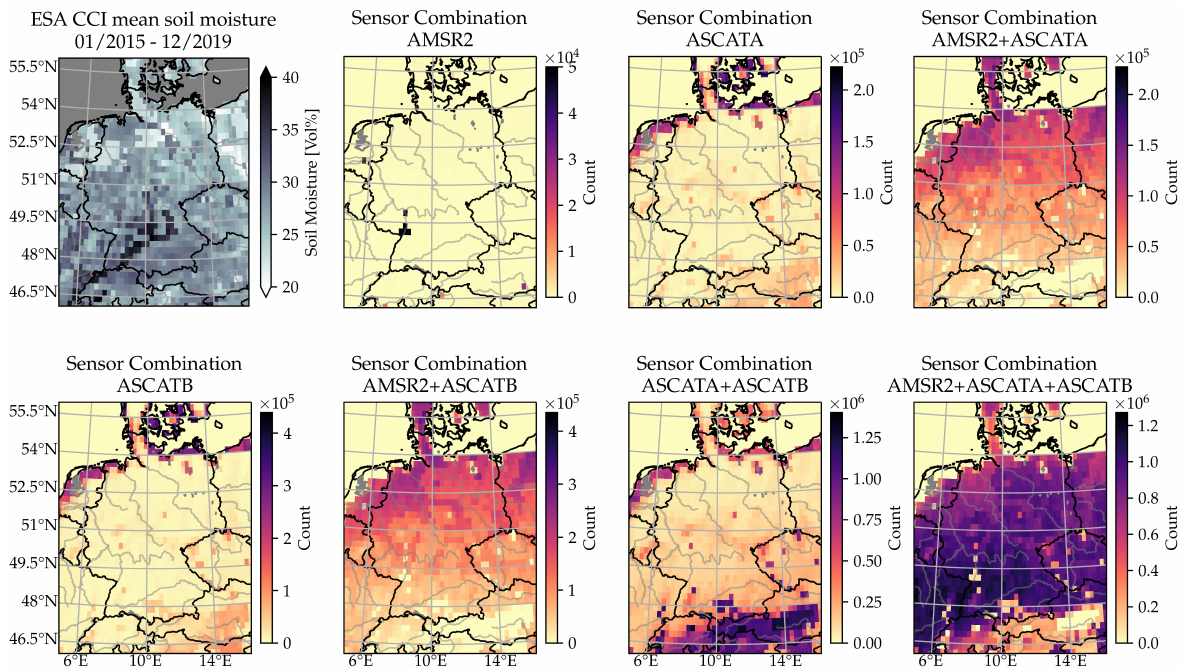
Figure A3. Mean soil moisture from ESA CCI SM for the period of 01/2015 to 12/2019 and counts of different sensor combinations contributing to the merged product. For respective combinations see ESA CCI SM product